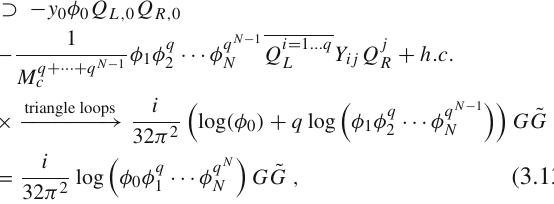
of the mass terms or a number of fermions that grows with N (or both). The situation is illustrated in Fig. 2: even though the use of q (cid:10)= 1 enables the dimension of the first U ( 1 ) a - breaking operator to scale exponentially with respect to the number of quiver groups, the number of fermions necessary to make U ( 1 ) a anomalous scales linearly with respect to this operator dimension [the number of fermions is bounded above by 1 + q + · · · + q N , realized in (3.11), and we bound + q +···+ q N it below by 1